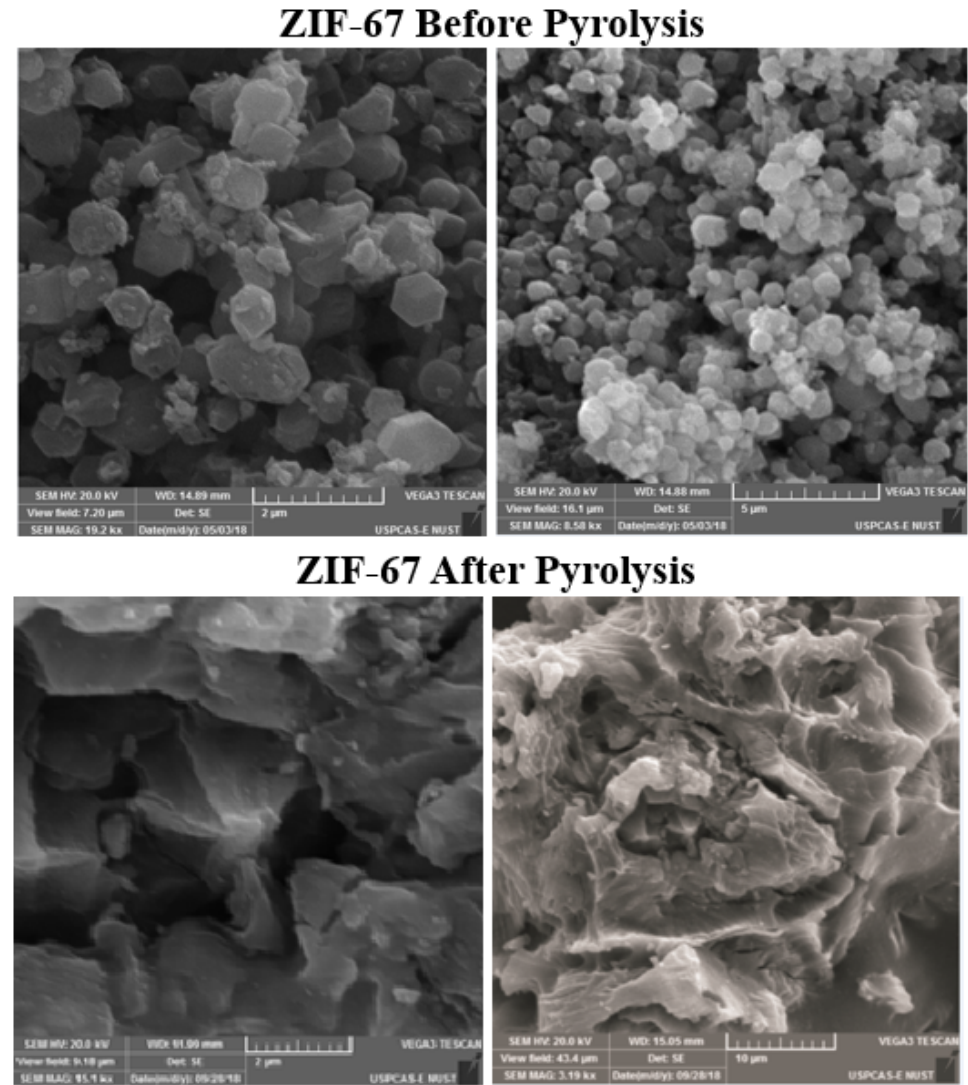
Figure 1. Surface morphology of MOFs ZIF-67 before and after pyrolysis. However, as the concentration is increased further, the added ZIF-67 seems to aggre- gate in Figure 2. Due to the agglomeration of the nanoparticles in the composite, the sur- faces became porous and clustered with the increased concentration of the ZIF-67. This may be attributed to the affinity of ZIF-67 to form aggregates above 5 wt.% concentrations [34]. The pyrolyzed ZIF-67 texture properties vary from non-pyrolyzed ZIF-67. Figure 3 shows the morphology of the surface of the PVA/starch blend films with pyrolyzed ZIF- 67. Pyrolyzed ZIF-67 shows a higher accumulation of nanoparticles on the surface in com- parison to the non-pyrolyzed ZIF-67 due to the high porosity [36]. The surface area of the pyrolyzed ZIF-67 increases, which forms more homogenous blends with PVA/starch and distributes ZIF-67 more uniformly, up to 4 wt.% of the ZIF-67 sample. Even after this com- position, the increase in the amount of pyrolyzed ZIF-67 in the composition showed less agglomeration and more dispersion compared to the pyrolyzed ZIF samples.